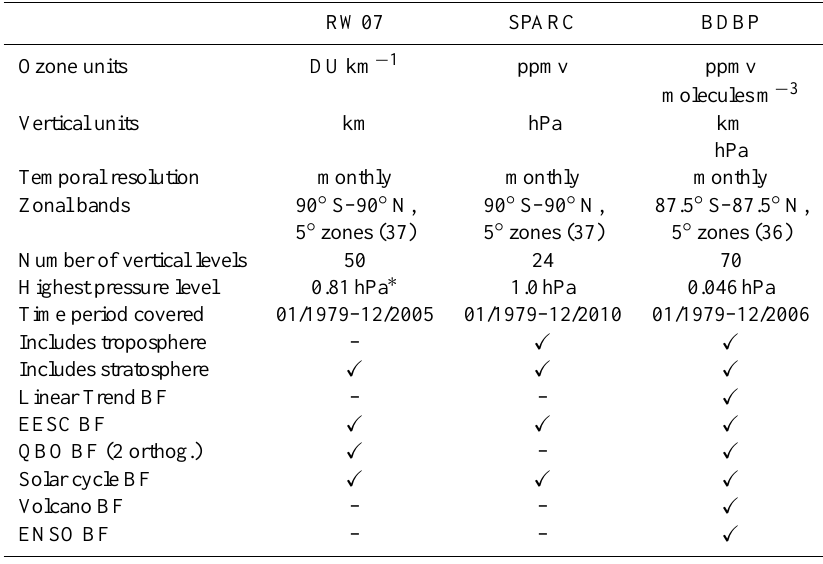
Table 1. Overview of the characteristics of the three different data sets and information about the basis functions (BF) included in the regression model that was used to create the data